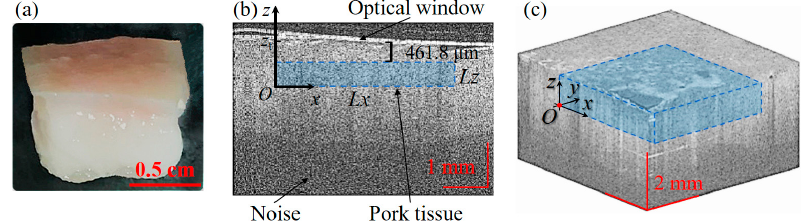
Figure 8. Pork sample. ( a ) A photo of the pork sample; ( b ) a central cross-sectional OCT image before deformation, where the ROI is marked with a blue rectangle; ( c ) a 3D OCT image before deformation, where the ROI is marked with a blue cube.